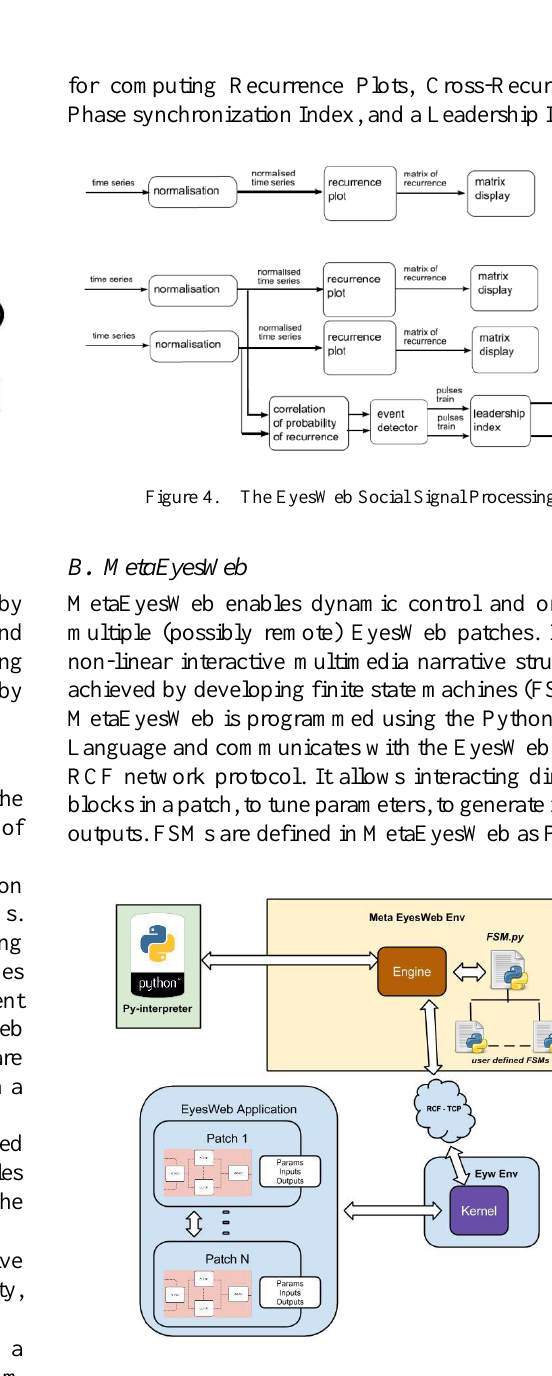
Figure 5. Interaction between MetaEyesWeb and